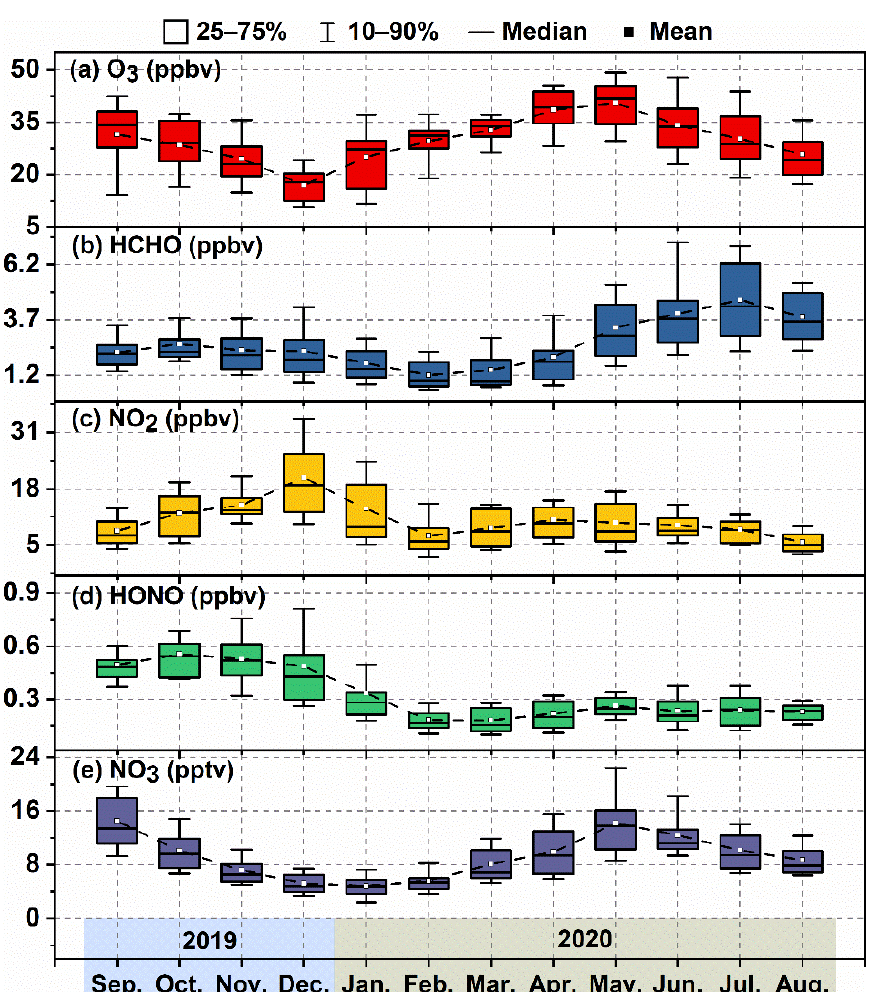
Figure 3. The monthly box charts of O 3 ( a ), HCHO ( b ), NO 2 ( c ), HONO ( d ), and NO 3 ( e ) from September 2019 to August 2020 in Nanhui, Shanghai. The monthly means are connected by black dotted lines.